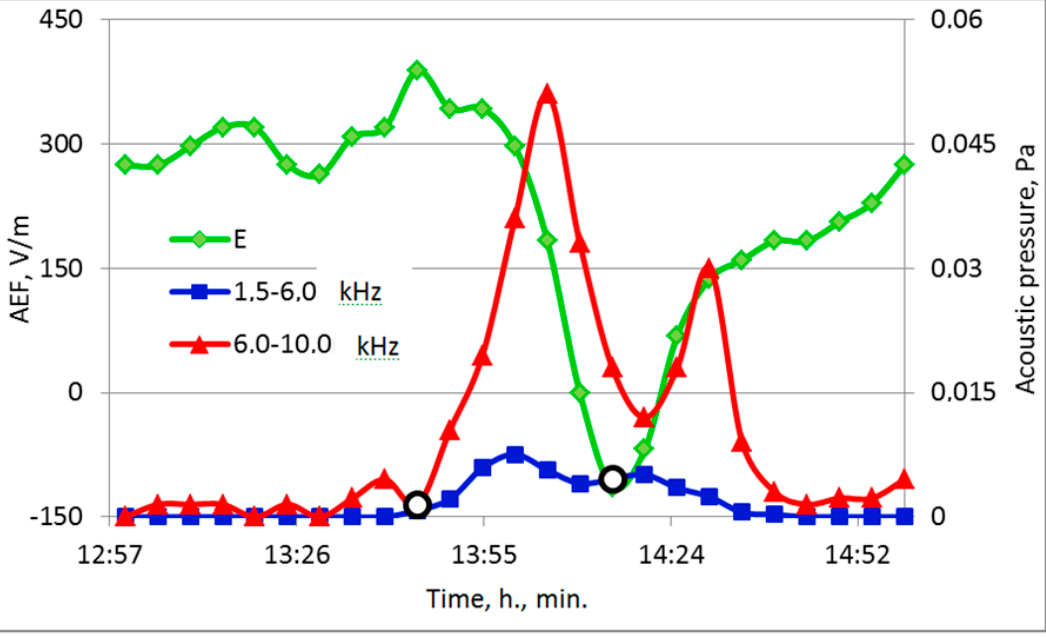
Figure 7. Decay of AEF as a result of a sharp increase in the pressure of seismoacoustic noise in the ranges 1.5–6.0 kHz and 6.0–10.0 kHz